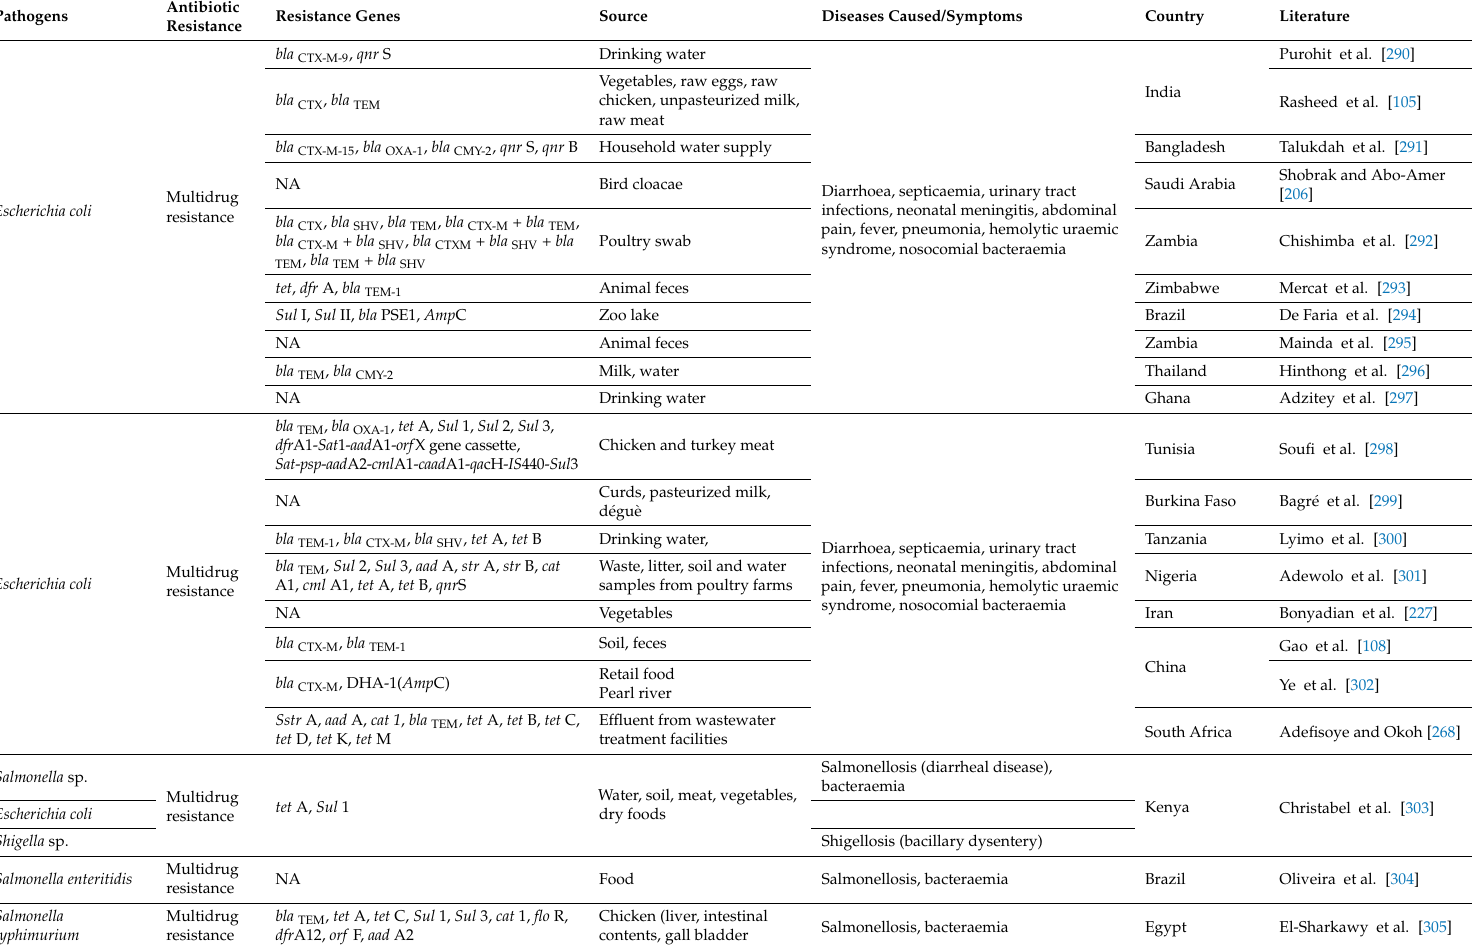
Table 2. Notorious pathogens, antibiotic resistance, and implicated resistance genes from environmental samples in some developing